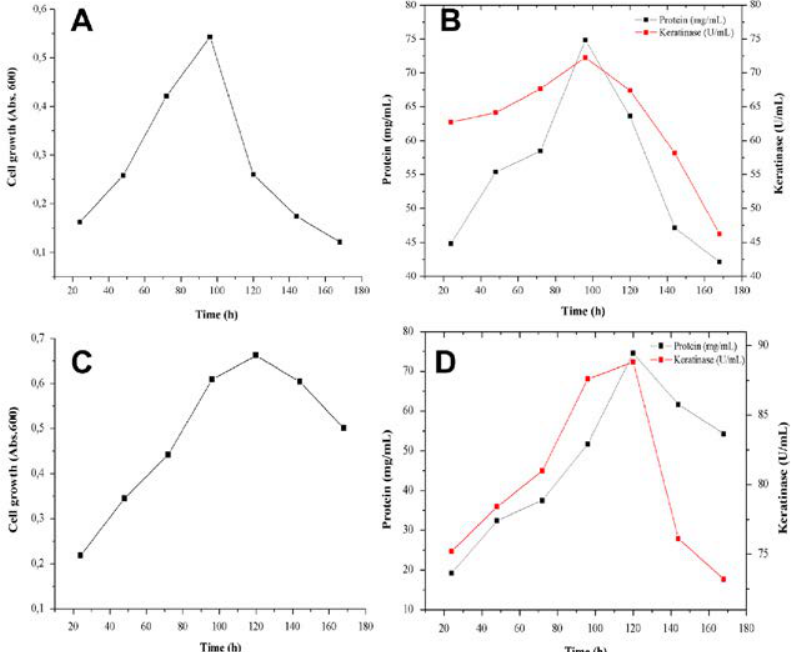
Fig. 4. Bacterial growth, keratinase activity and soluble protein release growth of A. chroococcum B4 on chicken feathers supplemented with C- and N- sources. Bacterial growth in medium supplemented with (a) 1% (w/v) sucrose (c) with 0.5% (w/v) peptone (b) Soluble protein and enzyme activity in medium supplemented with 1% (w/v) sucrose and (d) 0.5% (w/v)